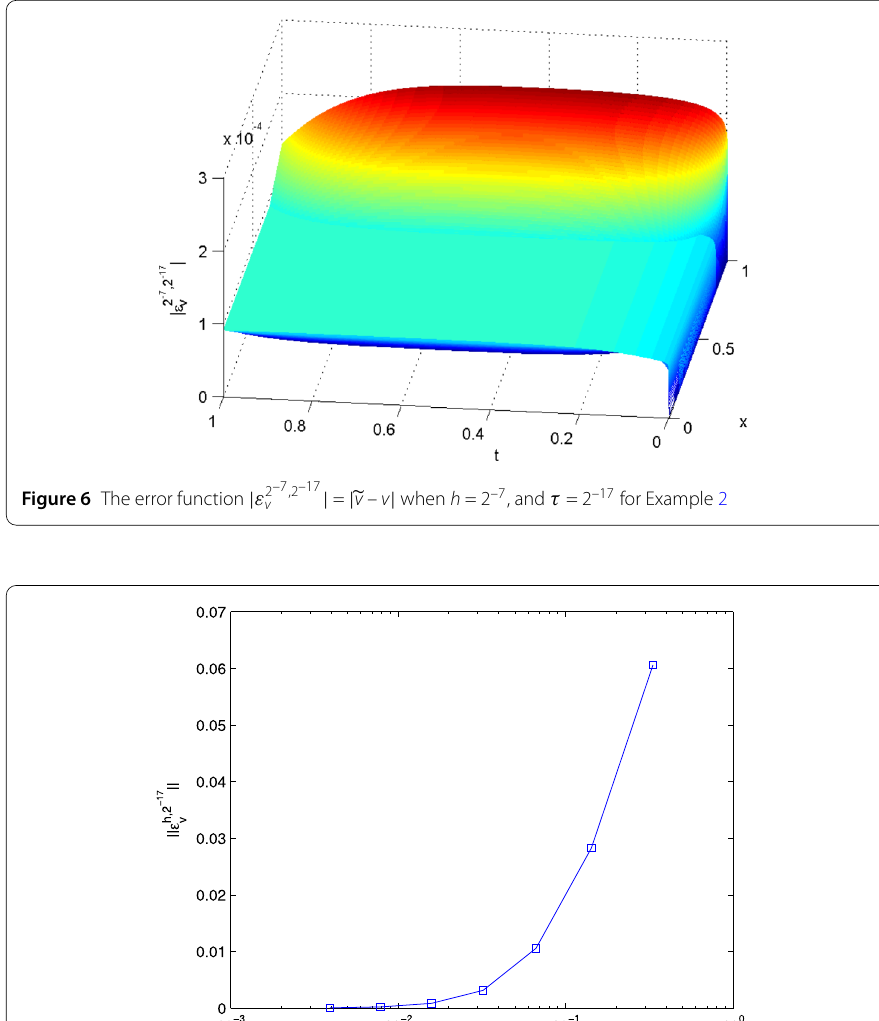
,2–17 (cid:7) for τ = 2 –17 , with respect to h for Example 2 v